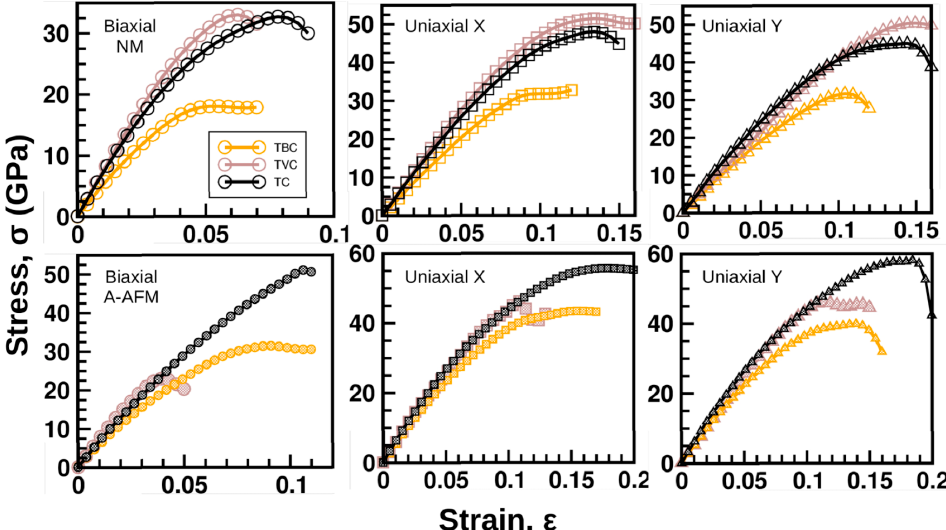
Figure 5. The stress-strain curve of Ti 2 C, Ti 2 (C 0.5 B 0.5 ) and (Ti, V)C under biaxial and uniaxial tensile strains along with the X and Y directions. The top panels show the results for NM states, while the bottom panels show the results for the minimum energy AFM magnetic state. Reproduced with permission from [ 51 ] . Copyright AIP Publishing, 2017.